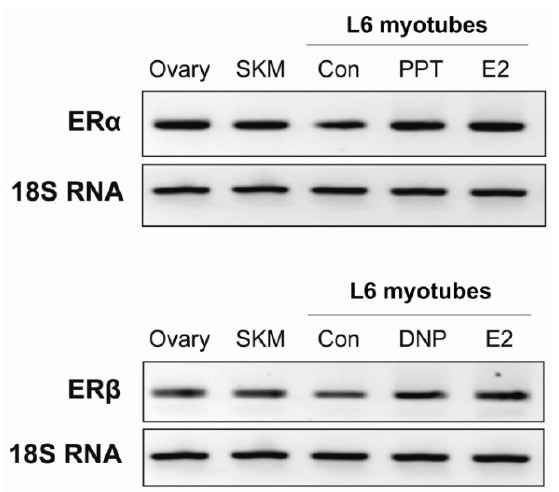
Figure 3. Expression of estrogen receptor α and β in rat skeletal muscle tissue and L6 skeletal muscle cells. Total RNA was extracted from the ovary and skeletal muscle (SKM) tissue of the rat, and L6 myotubes treated with 4,4 ′ ,4”-(4-propyl-[1H]-pyrazole-1,3,5-triyl) trisphenol (PPT), 2,3-bis(4-hydroxy-phenyl)-propionitrile (DPN) orEstradiol (E2). RNA was reverse transcribed to generate cDNA followed by semi-quantitative analysis using gene specific primers.